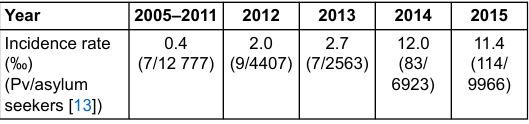
Table 1: Estimated P. vivax malaria incidence rate per 1000 Eritrean refugees in